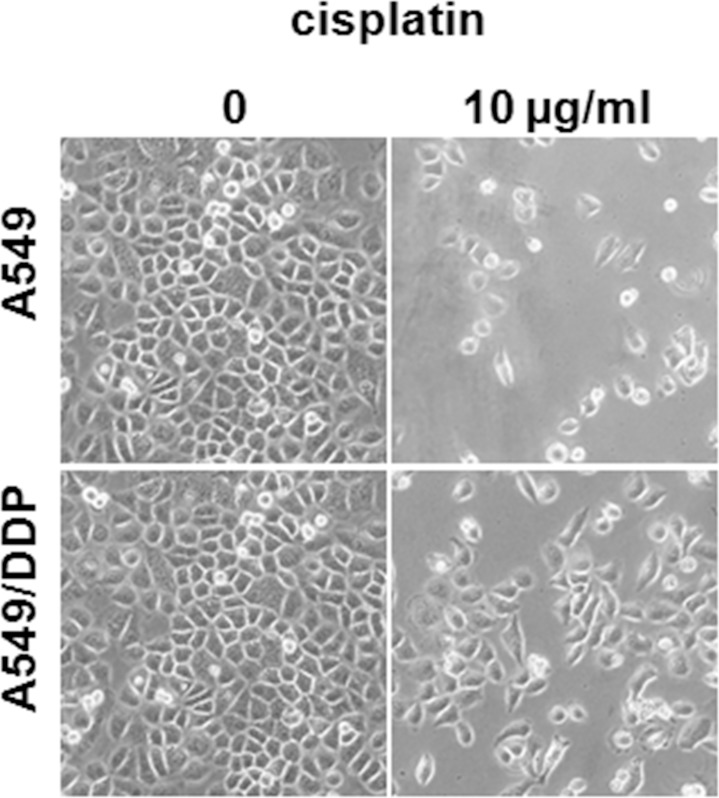
Cell morphology differences between A549 and A549/DDP cells.Micrographs showing A549 and A549/DDP cells cultured for 3 days in the absence or presence of cisplatin (10μg/mL).